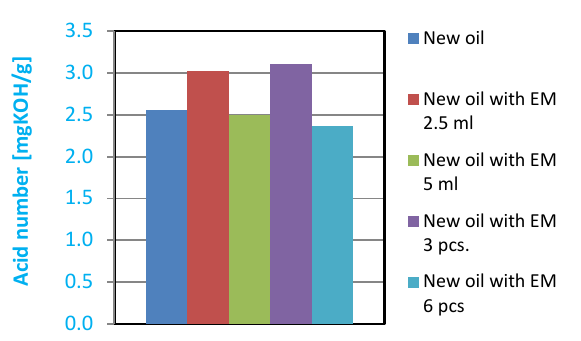
Fig. 5. Acid number of new oil and new oil with EM in liquid form and ceramic tubes As in the case of used oil, the effect of adding silver solution and colloidal nanosilver to new oil was also in- vestigated. The addition of 2.5 ml of colloidal nanosilver to the oil increases the acid number to the level of 2.668 mgKOH/g, and in the amount of 5 ml to the level of 2.659 mgKOH/g.